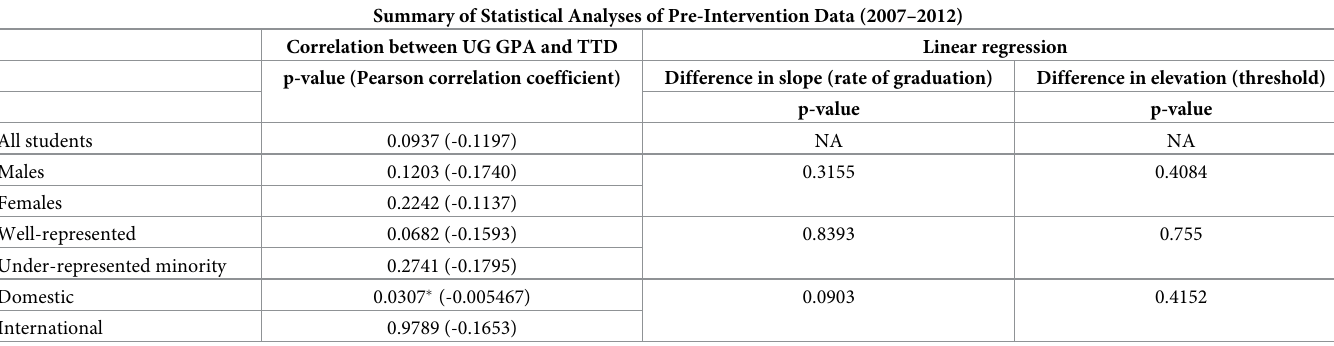
Table 2 outlines the statistical analyses that were conducted on each data set regarding undergraduate GPA and time to degree. The only statistically significant correlation that was observed was for domestic students with a p value of 0.0307. No statistically significant differences in slope or elevation were observed in any categories. � p �